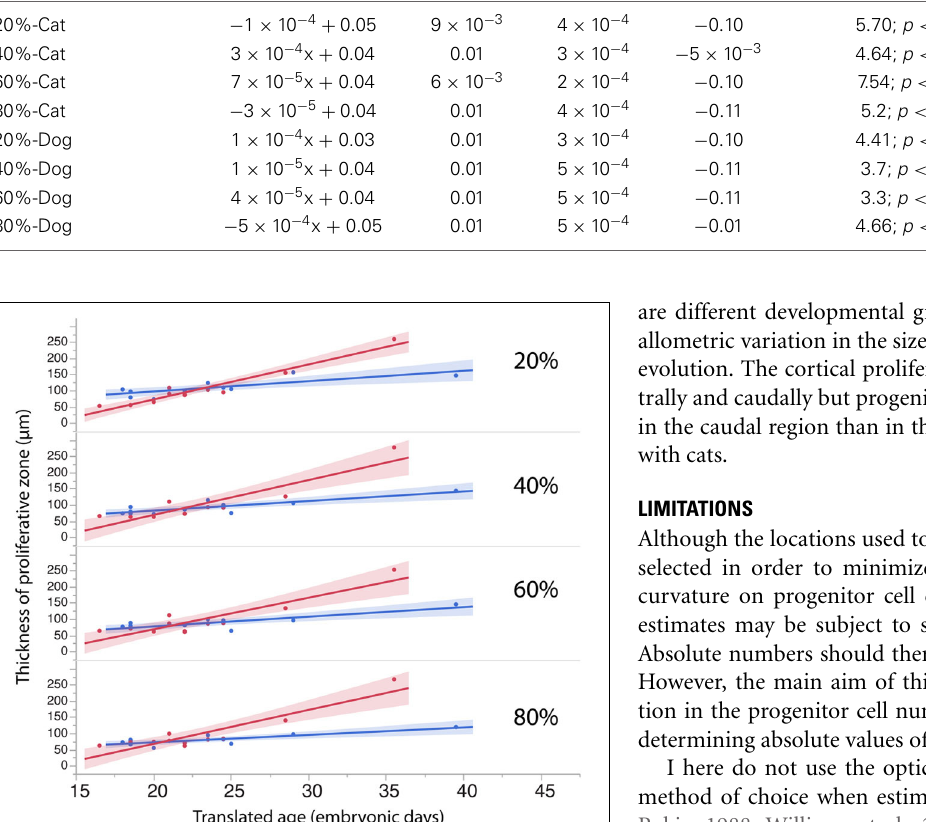
Table 4 | Summary of statistical parameters for the cell density of the proliferative zone regressed against translated age in cats and dogs. Rostro-caudal location